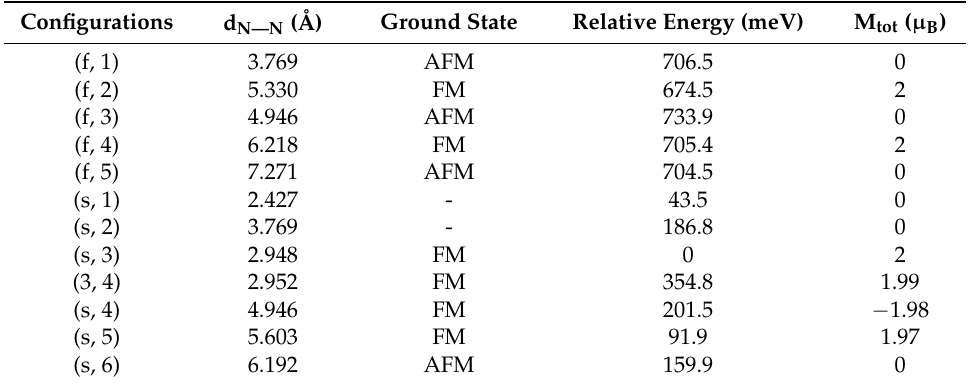
Table 1. Values of N ··· N distance ( d N—N ) (Å), magnetic ordering of ground state, relative energy, and total magnetic moment ( M tot ) calculated for each configuration of two nitrogen (N) atoms doped in BiFeO 3 (BFO) with G-antiferromagnetic (AFM) ordering. The energy difference between ground state of each configuration and C S3 configuration is the relative energy. The negative value of magnetic moment denotes its direction is downward.